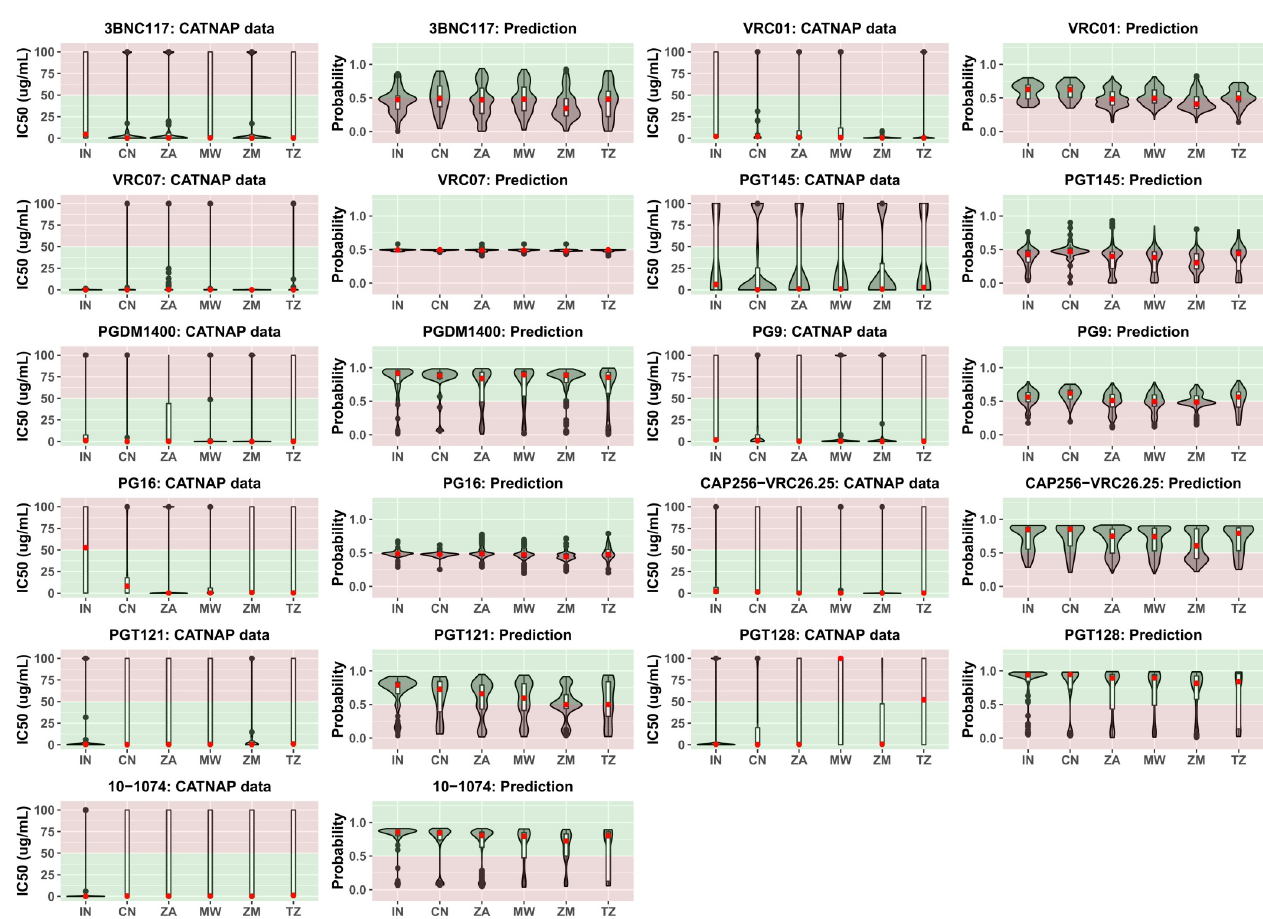
Fig 6. Prediction of bnAb sensitivity across different countries. Each panel indicates available country-wise CATNAP data plotted next to country-wise prediction data for available sequences for 3BNC117, VRC01, VRC03, VRC07, VRC13, CAP256:VRC26.25, PGDM1400, PG9, PG16, PGT145, PGT121, and PGT128 and 10–1074. In the CATNAP data panels, country-wise violin plots have been inlayed with boxplots against reported IC50 ( μ g/mL) values. Black dots indicate outliers while red dots indicate median values. Red background zone indicates bnAb resistance (IC50 > 50 μ g/mL) while green background zone indicates bnAb sensitivity (IC50 < 50 μ g/mL). In the bNAb-ReP data panels, country-wise violin plots have been inlayed with boxplots against probability of neutralization as predicted by bNAb-ReP. Black dots indicate outliers while red dots indicate median values. Red background zone indicates probable bnAb resistance (Neutralization probability < 0.5) while green background zone indicates probable bnAb sensitivity (Neutralization probability > 0.5).